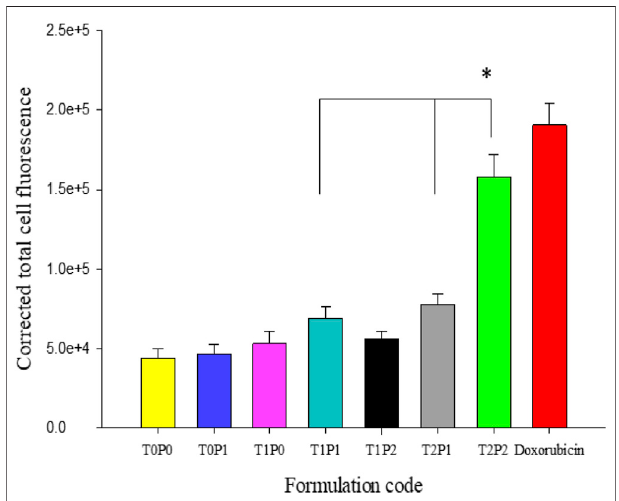
FIGURE 4 | The values of calculated corrected total cell fl uorescence intensity within SW620 cells, based on the outcomes shown in Figure 3 (data present mean ± SD, number of cells counted (cid:1) 50, * p (cid:1) < 0.001).